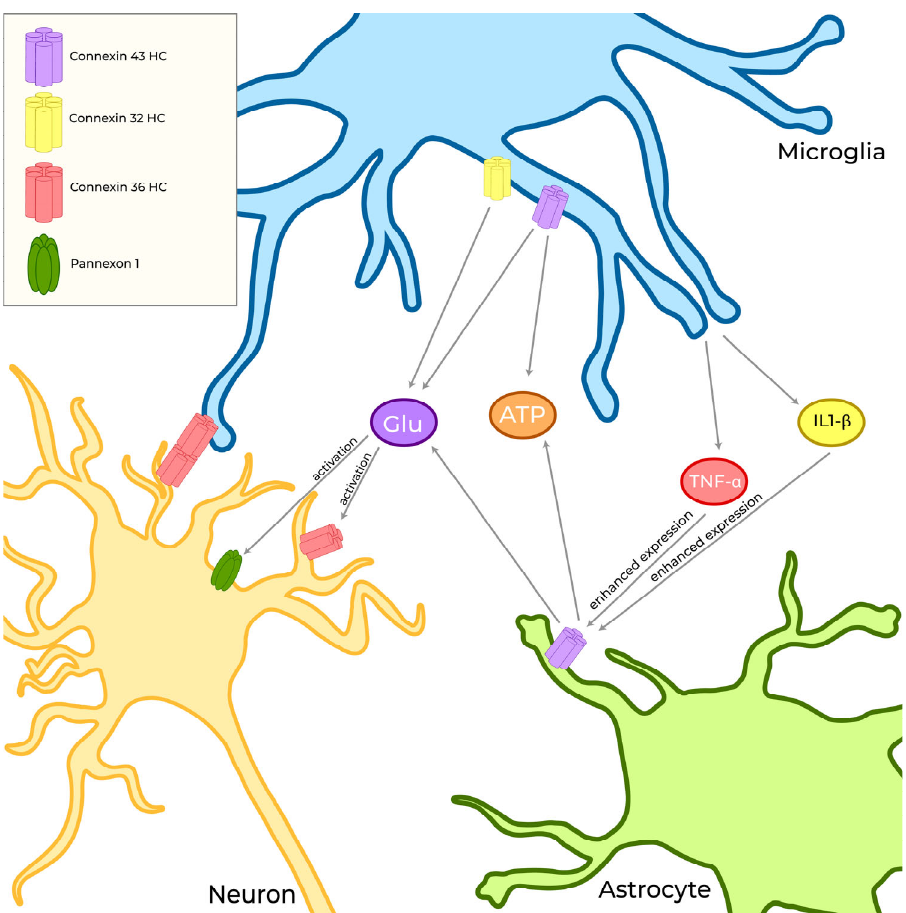
Figure 5. Cxs expressed by microglia are fundamental for their interaction with other cells of the CNS. This interaction occurs both indirectly, through the release of metabolites such as glutamate (Glu), ATP, TNF- α , and IL1- β that can up-regulate or modulate HCs in neurons and astrocytes, and directly, involving the formation of Cx36 GJs between microglia and neurons.